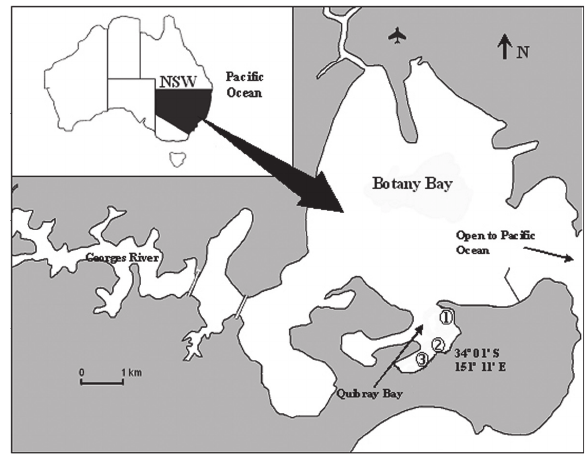
Fig . 1. – Map of Botany Bay, showing the position three sampling sites in Quibray